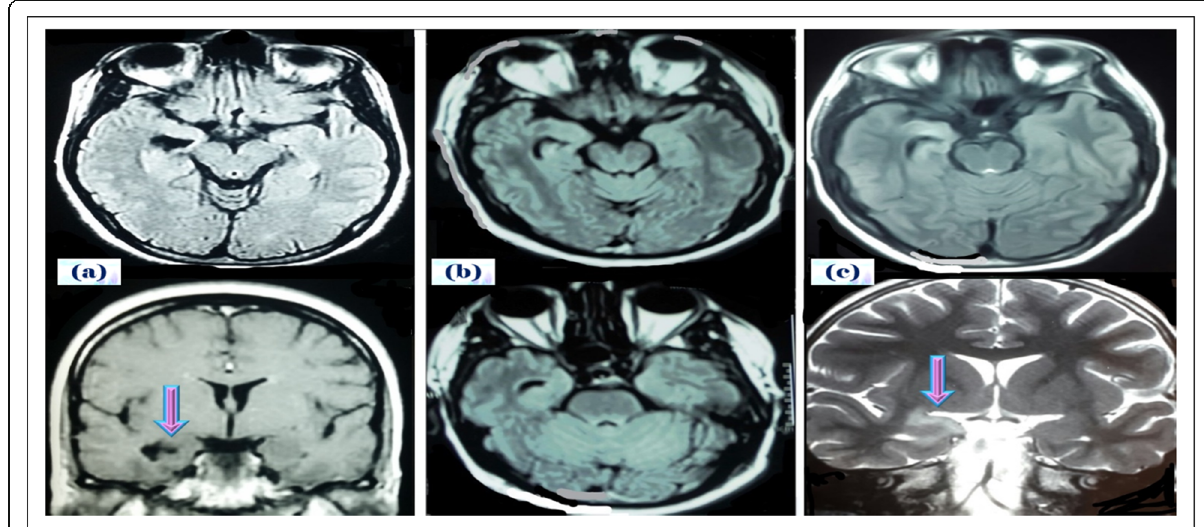
Fig. 1 Magnetic resonance imaging of 3 drug-resistant epilepsy cases ( a , b, and c ) with right mesial temporal sclerosis